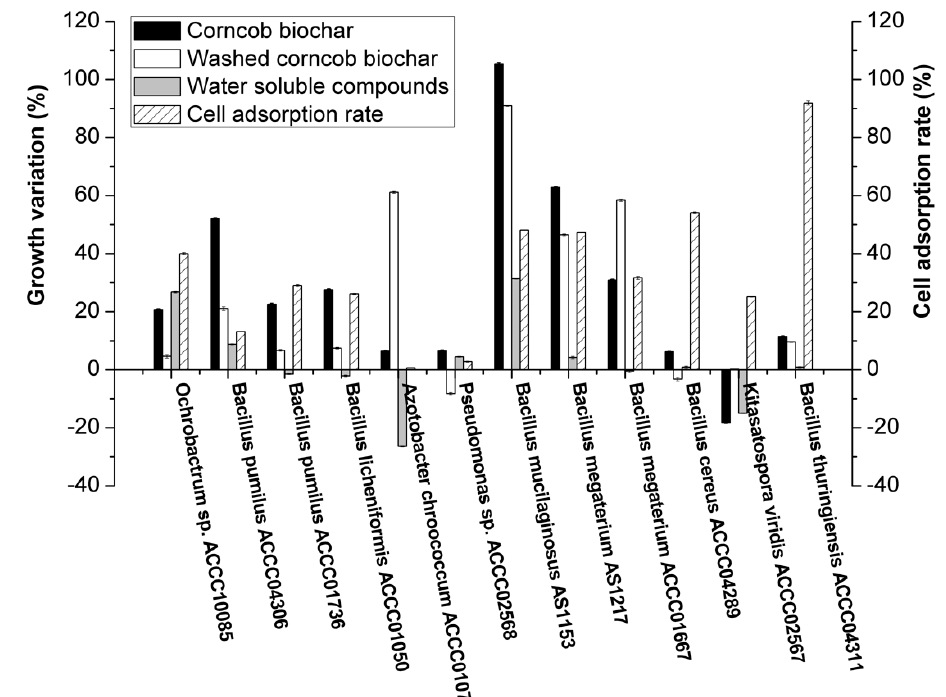
Figure 4. Impact of corncob biochar adsorption and its water-soluble compounds on bacterial growth in the artificial medium.